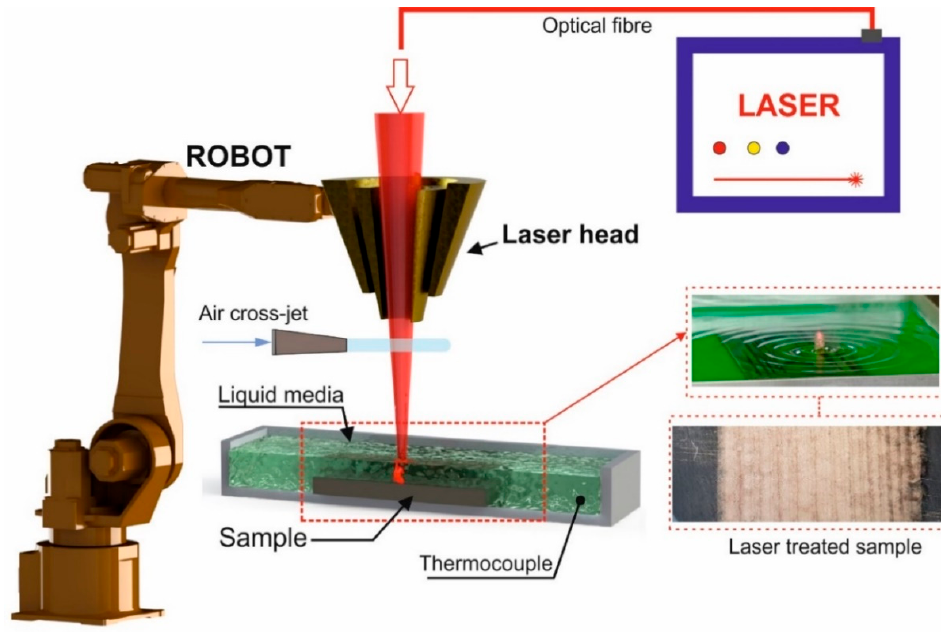
Figure 1. Principle of the laser heat treatment in the nickel acetate liquid media.